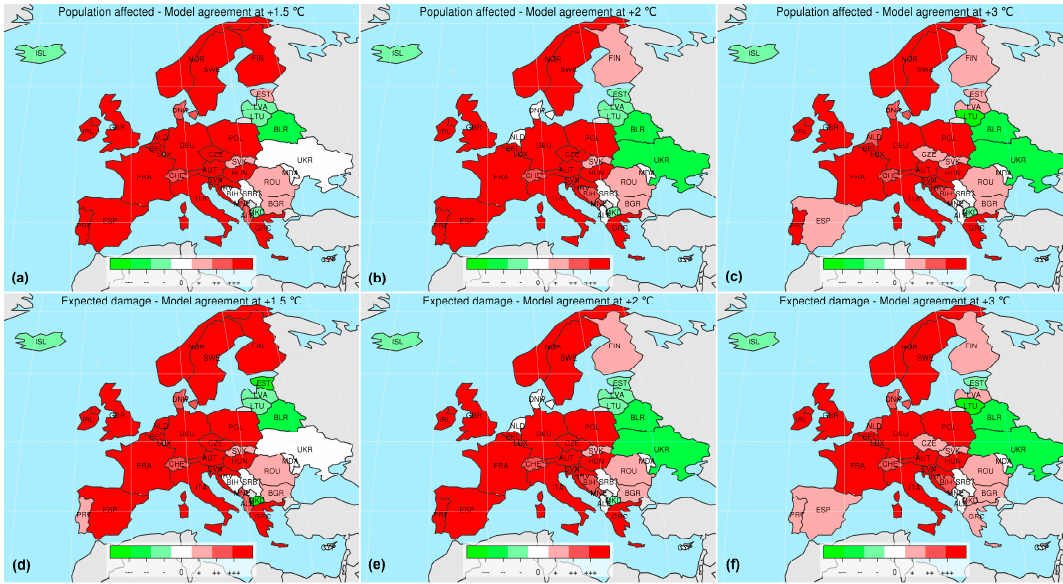
Figure 4. Multi-model agreement of projected changes in affected population ( a – c ) and expected damage ( d – f ) at specific warming levels (SWLs): 1.5 °C ( a , d ), 2 °C (b,e), and 3 °C ( c,f ). Colors depend on the number of cases predicting a positive or negative change in impacts.